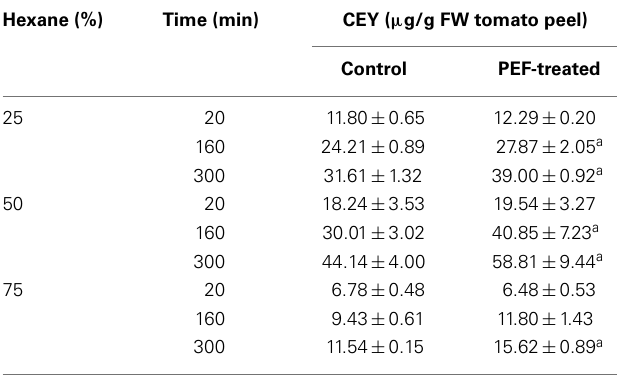
Table 1 | Effect of percentage of hexane and extraction time on the carotenoid extraction yield (CEY) from tomato peel non-treated (control) and PEF-treated .